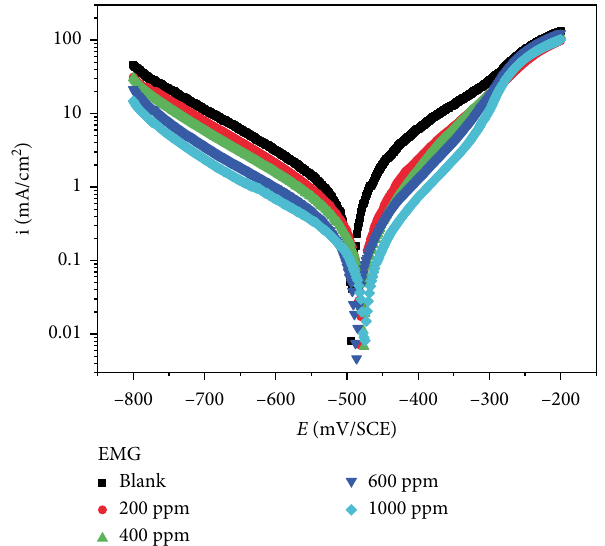
Figure 5: Polarization curve of mild steel in 1M HCl with and without addition of different concentrations of EMG at 303